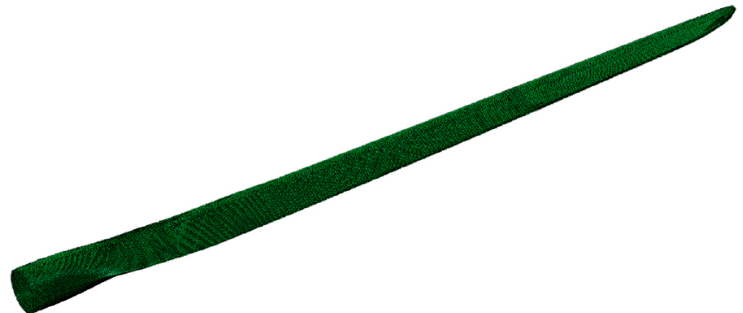
Figure 2. Composite wind turbine blade model. Table 1. Mechanical properties.